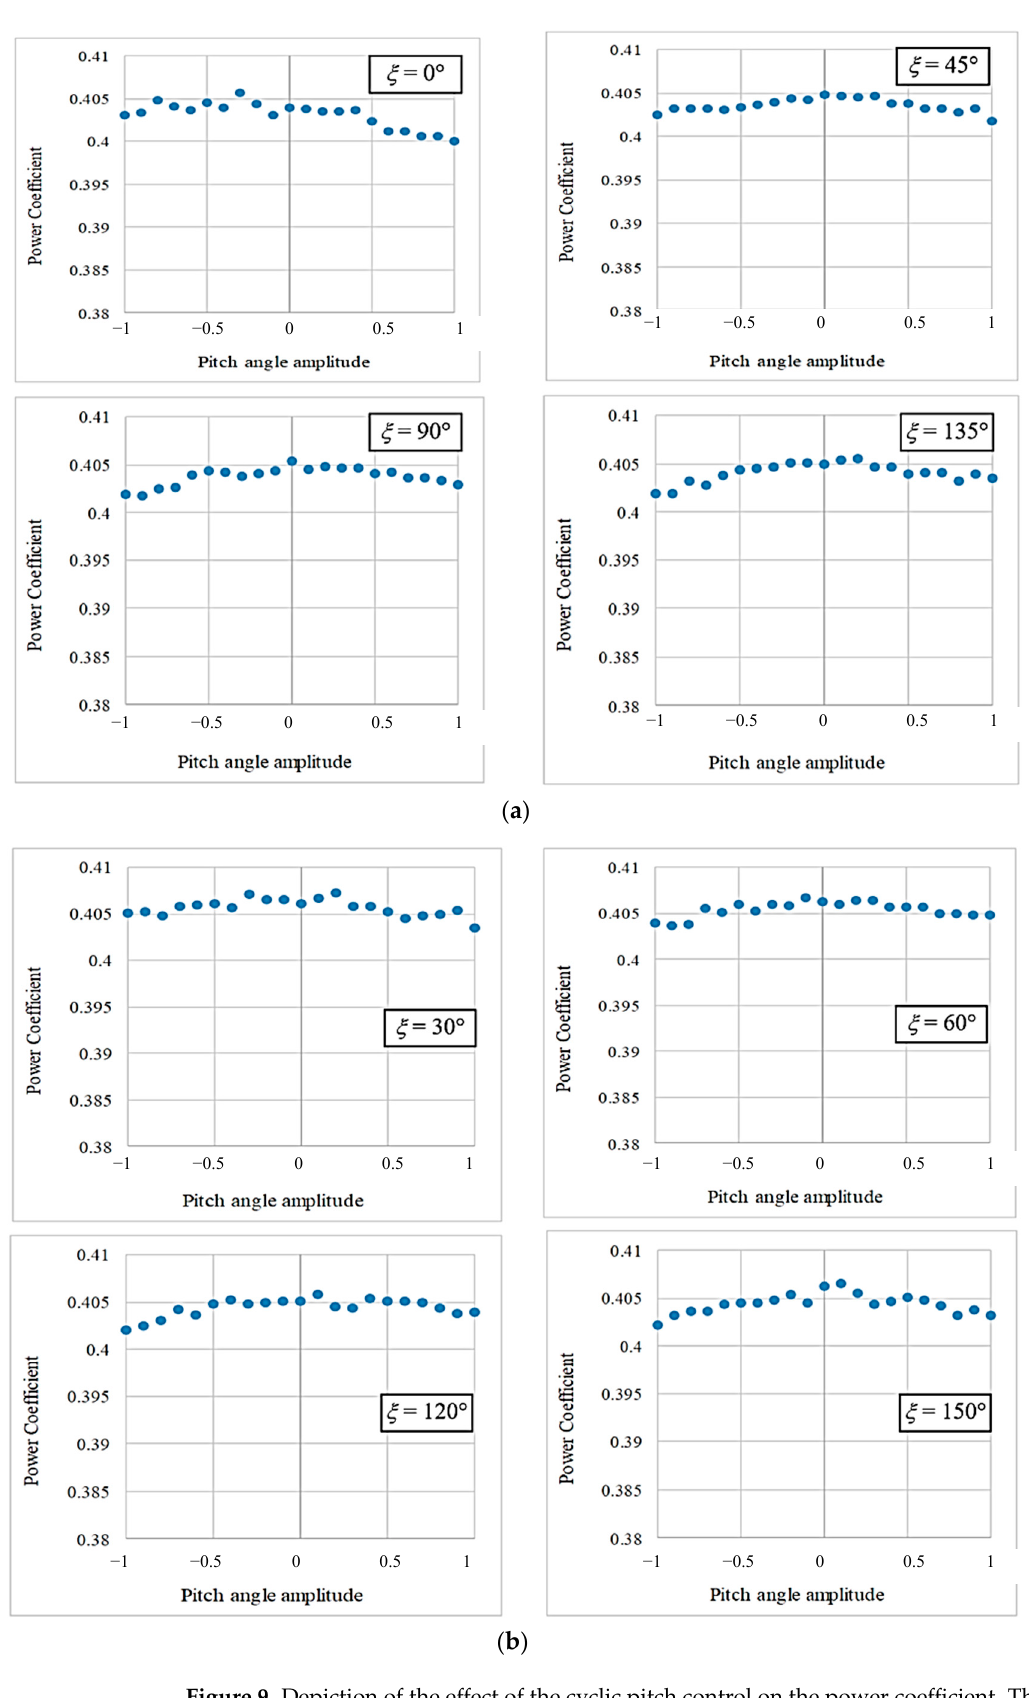
Figure 9. Depiction of the e ff ect of the cyclic pitch control on the power coe ffi cient. The phase angle is divided into two cases of ( a ) ξ = 0°, 45°, 90°, and 135°, and ( b ) ξ = 30°, 60°, 120°, and 150°. For the cyclic pitch control as Equation (1), the pitch angle of the blade is calculated by a cosine function. When the rotor turns repeatedly in a rotation from 0 o to 360 o , it leads to the azimuth angle of the pitch angle fl uctuating according to the azimuth angle rotation. The power coe ffi cient at the phase angle of ξ = 0° has stronger fl uctuation than others as exhibited in Figure 9. This can be seen as the angle phase changes, and the power coe ffi - cient oscillates following the pitch-angle amplitude. Therefore, the power coe ffi cient of the wind turbine can be a ff ected by the azimuth angle rotation. In addition, the maximum power coe ffi cient depends on the azimuth angle rotation in the pitch-angle amplitude range from − 1° to 1°; this happened due to the azimuth angle rotation. The value of the maximum and minimum of the pitch angles depends on each phase angle. The fl uctuation of the power coe ffi cient at the pitch angle di ff ering from 0° is smoother than the phase angle of ξ = 0°. Therefore, it is controlled by the cyclic pitch control when the azimuth angle rotates. 3.3. Moments on the FOWT In this study, the slope of the moments (pitching and yaw moment) is called the mo- ment axis angle ψ M , and the equation for deriving ψ M from C Mx ( ξ , a ), C Mz ( ξ , a ) is shown in the following equation: